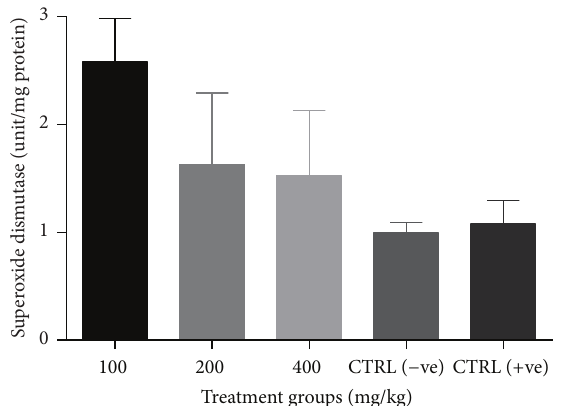
Figure 6: Effect of combined extracts of Azadirachta indica and Khaya senegalensis on superoxide dismutase (SOD) activity of the intestine of chickens infected with Eimeria